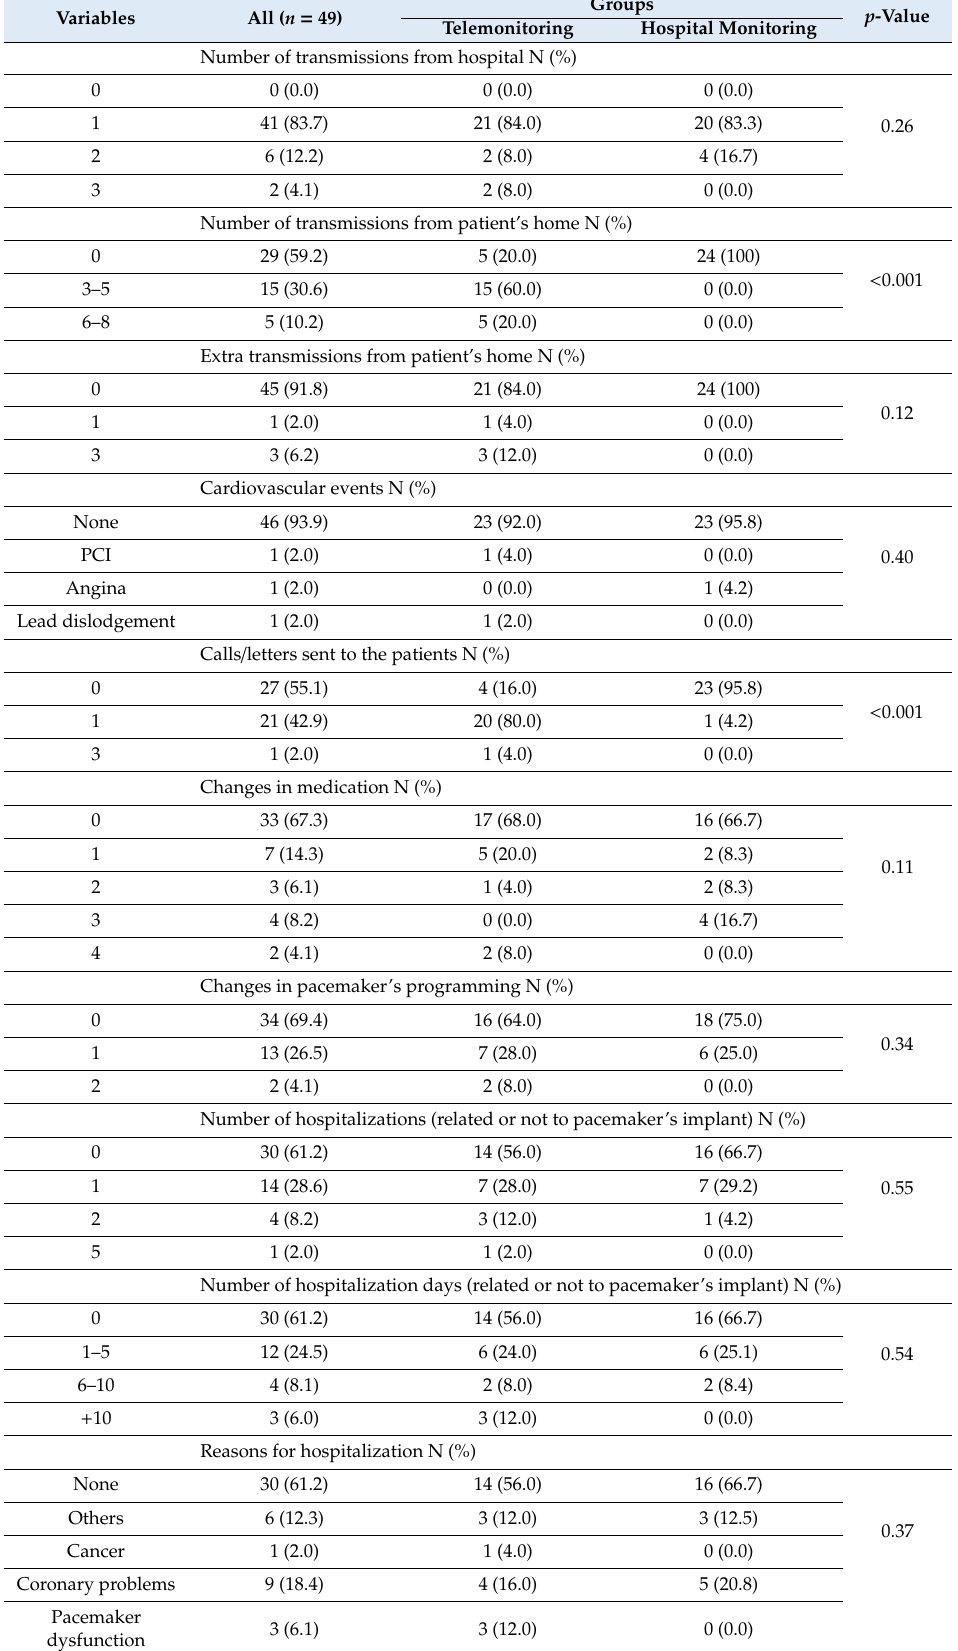
Table 4. Follow-up general information at six